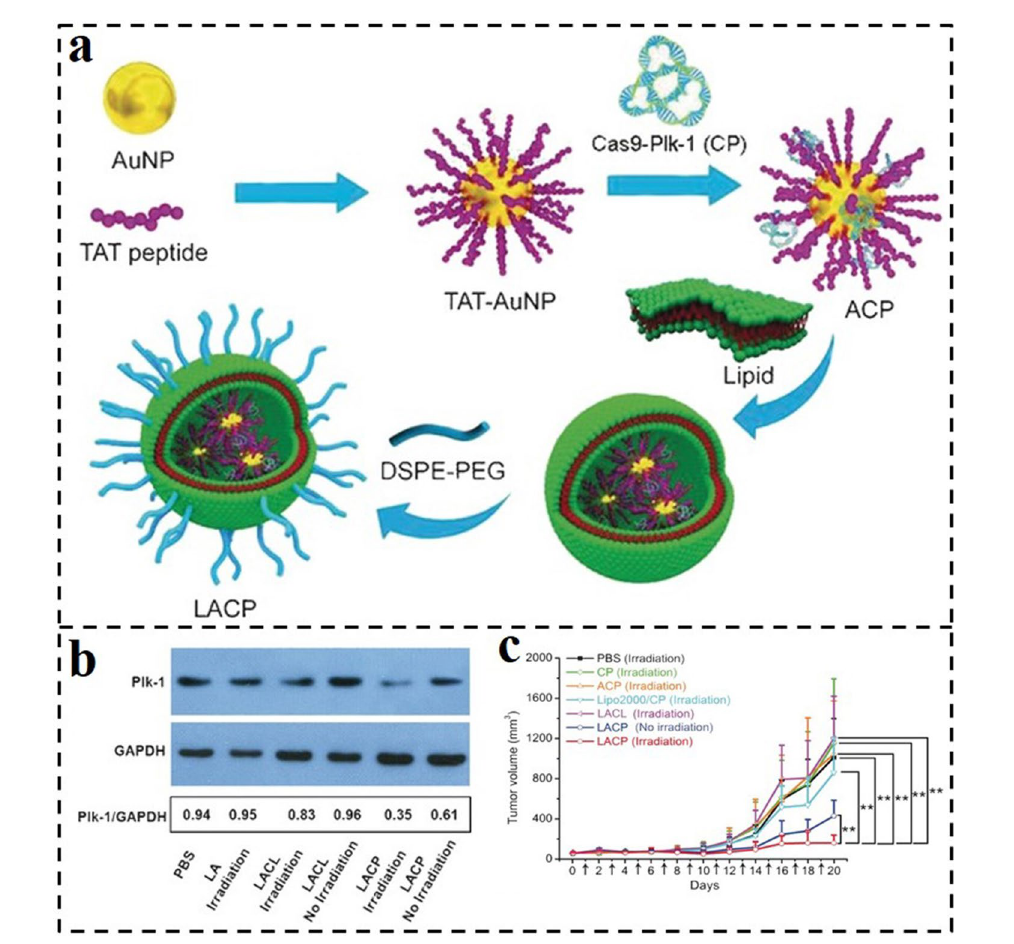
Fig. 15 a Synthesis process for LACPs. b Western blot analysis of the Plk-1 protein expression in A375 cells treated by different CP formula- tions with or without laser irradiation. c Sizes of tumors treated with different CP formulations [180]. Copyright 2019, Wiley–VCH